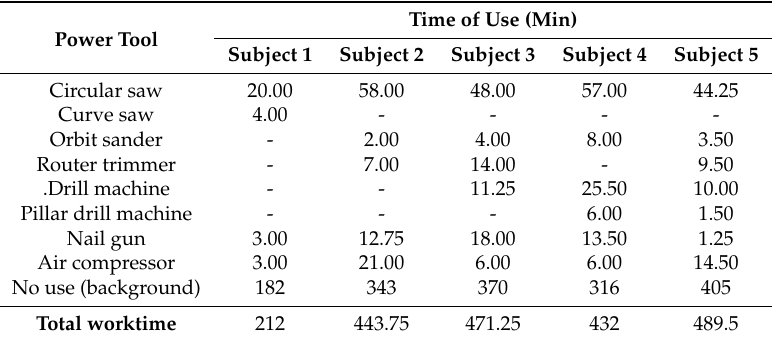
Table 1. Information of time of tool use for woodworkers.